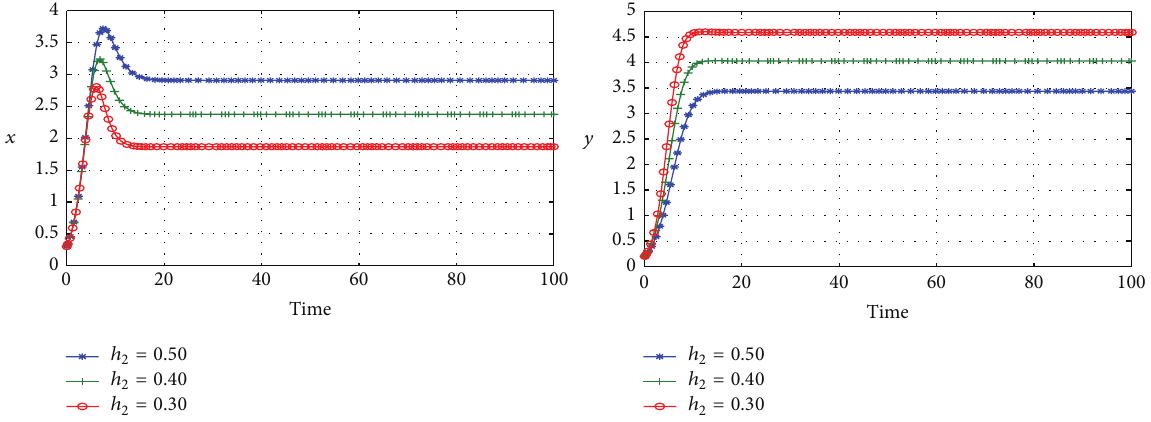
Figure 1: When ℎ 1 = 0.4 and ℎ 2 decreases, prey species 𝑥 decreases and predator species 𝑦 increases.